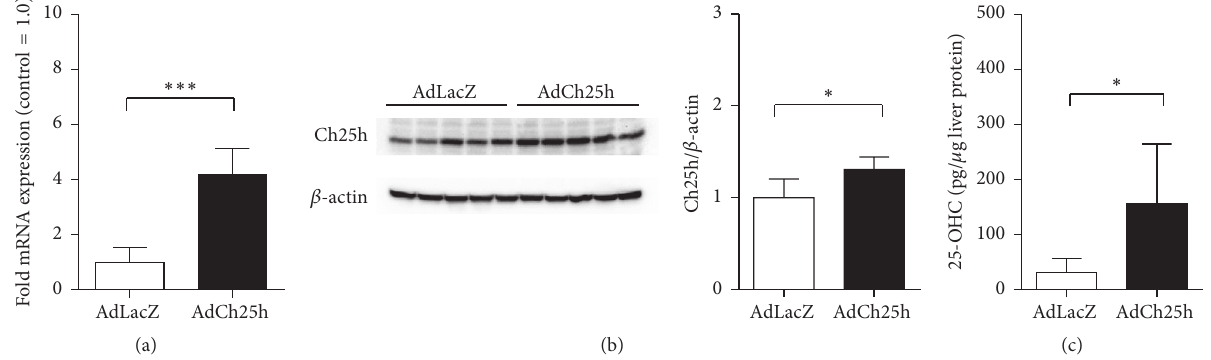
Figure 4: Tail vein injection of adenoviral Ch25h showed a successful hepatic Ch25h and 25-hydroxycholesterol overexpression. (a) Relative Ch25h levels in AdLacZ and AdCh25h transduced livers. mRNA levels of hepatic Ch25h levels increased 5-fold compared to AdLacZ injected controls. ∗∗∗ 𝑝 < 0.001 , 𝑛 = 5 per group. (b) Ch25h immunoblot of AdLacZ and AdCh25h transduced liver biopsies. Ch25h protein levels are clearly increased in livers of AdCh25h treated mice compared to AdLacZ transduced controls. 𝛽 -Actin was used as a loading control. ∗ 𝑝 = 0.034 , 𝑛 = 5 per group. (c) 25-OHC levels in AdLacZ and AdCh25h transduced livers. 25-OHC levels are significantly increased in livers of AdCh25h treated mice compared to AdLacZ transduced controls. ∗ 𝑝 = 0.035 , 𝑛 = 5 per